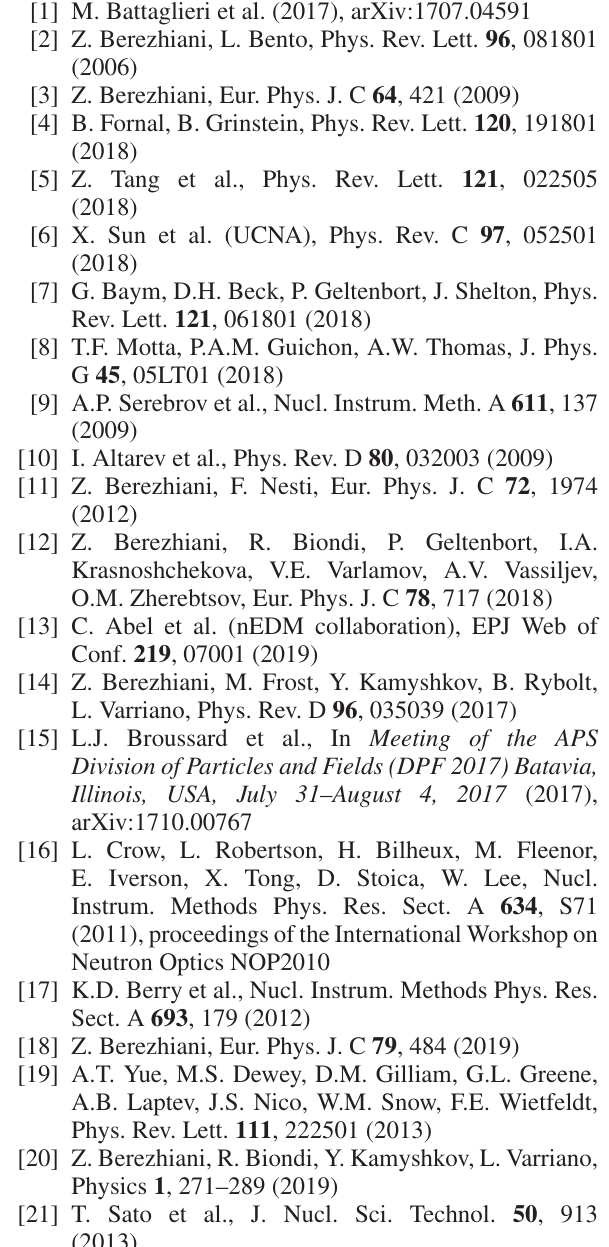
Figure 4. Magnetic field gradient (blue) and decoherence length (red) for 4.75 ˚A neutrons in a superconducting magnet available at GP-SANS used to calculate sensitivity for a neutron TMM search. The location of the beamstop is indicated by the black vertical